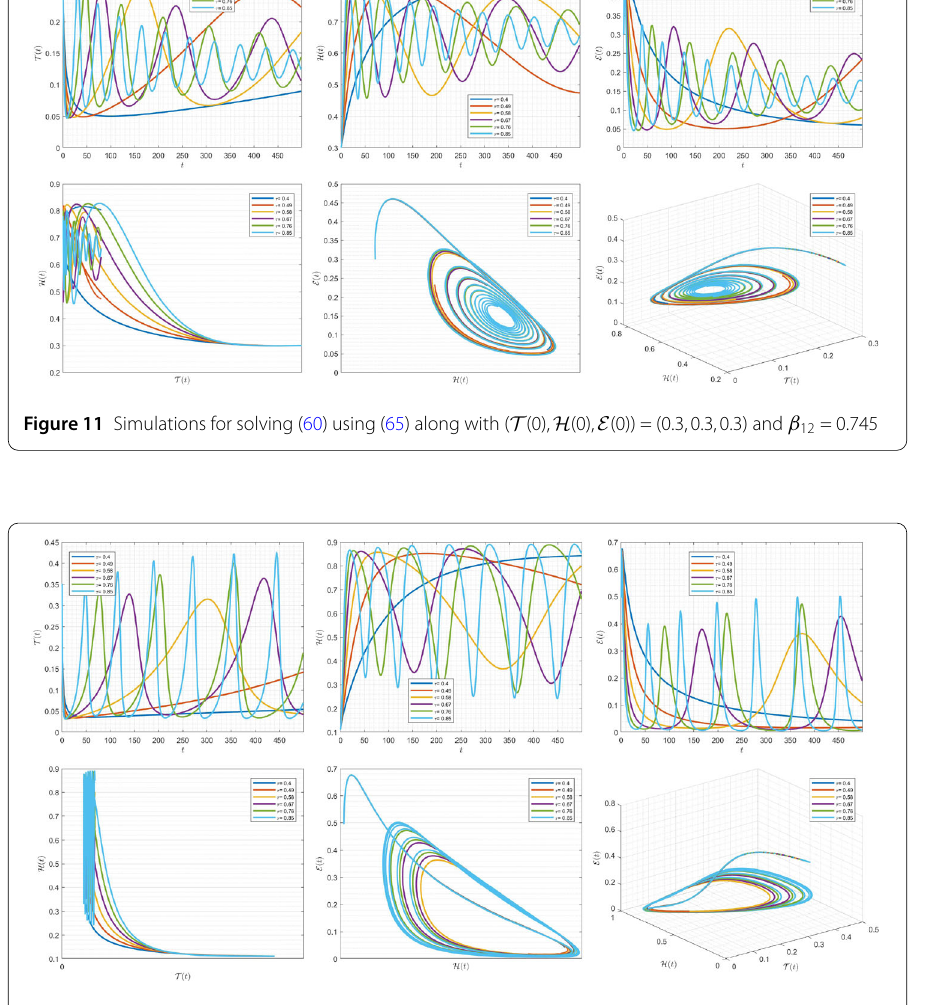
Figure 12 Simulations for solving (60) using (65) along with ( T (0), H (0), E (0)) = (0.3517,0.1115,0.4951) and β 12 =